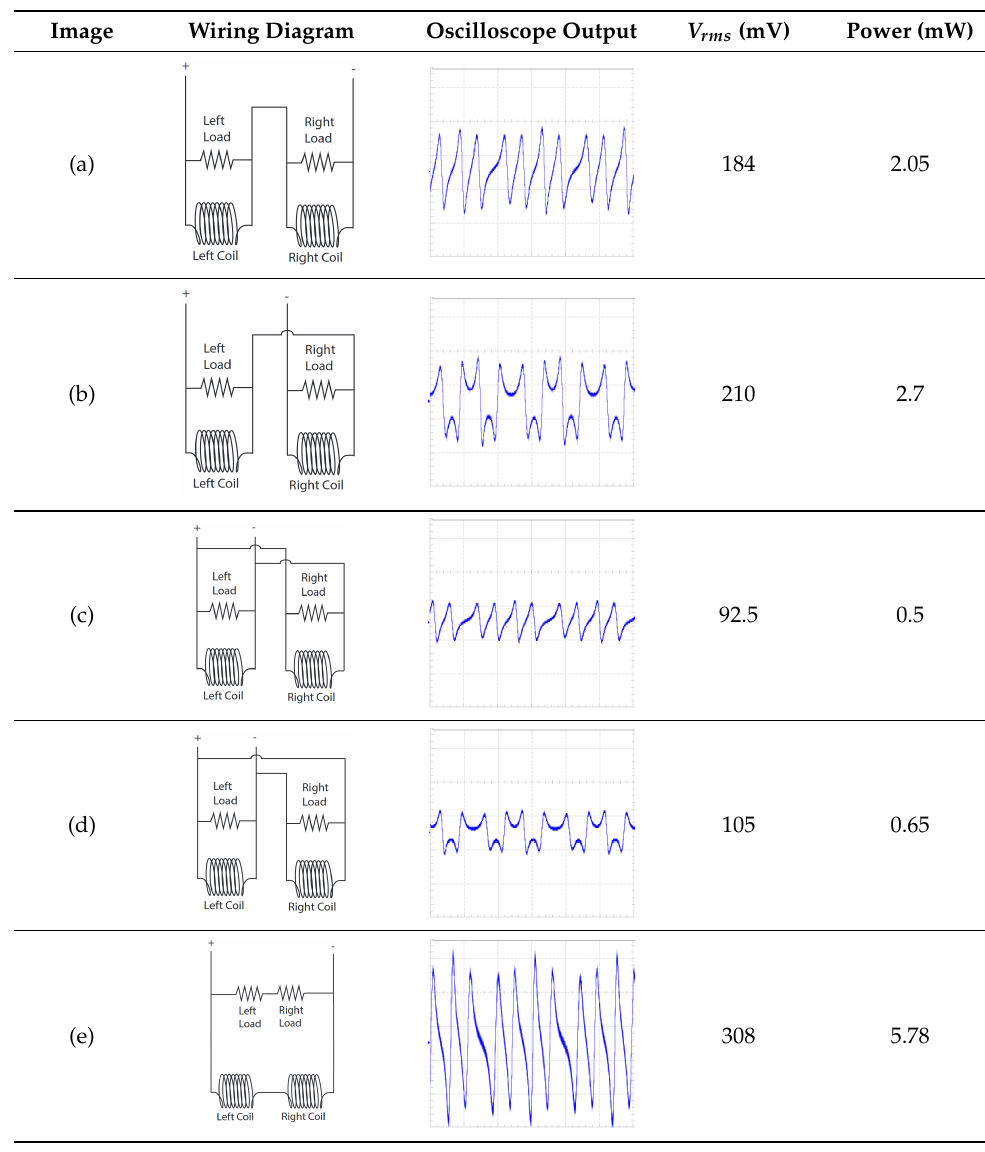
Table 1. Output of V-twin harvesters in both series and parallel configuration at 2 Hz. (a) each cylinder and its respective load resistance of 8.2 Ω were wired in series as units. The resulting total load resistance was 16.4 Ω . (b) the output leads of the right cylinder were interchanged from the system shown inimage (a). (c) each cylinder and its respective load resistance of 8.2 Ω in parallel as units. (d) the output leads of the right cylinder were switched from the system shown in image (c). In (e), each cylinder was wired in series and both loads were wired in series; however, both cylinders were kept in parallel with both loads. In (f), the output leads of the right cylinder were switched with those from the system shown in image